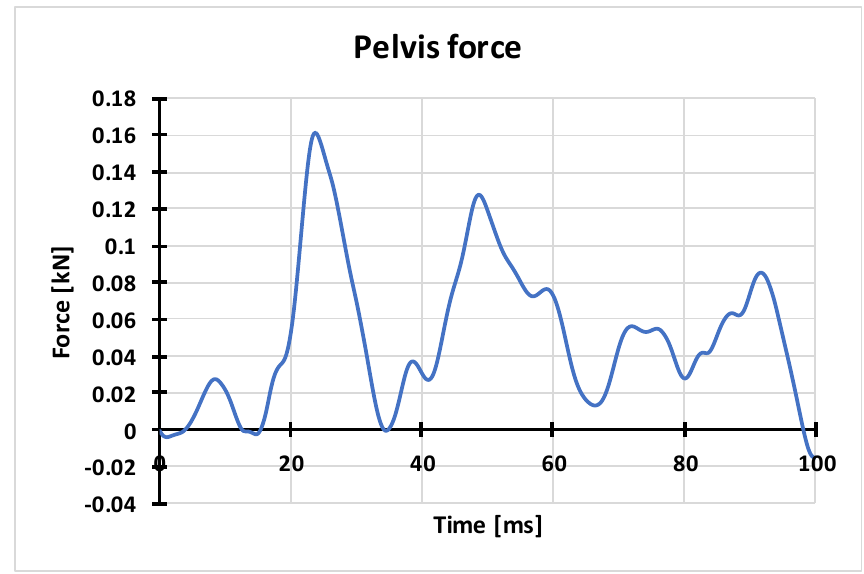
Figure 12. Characteristic of pubic force obtained on the basis of numerical calculations. Appl. Sci. 2019 , 9 , x FOR PEER REVIEW